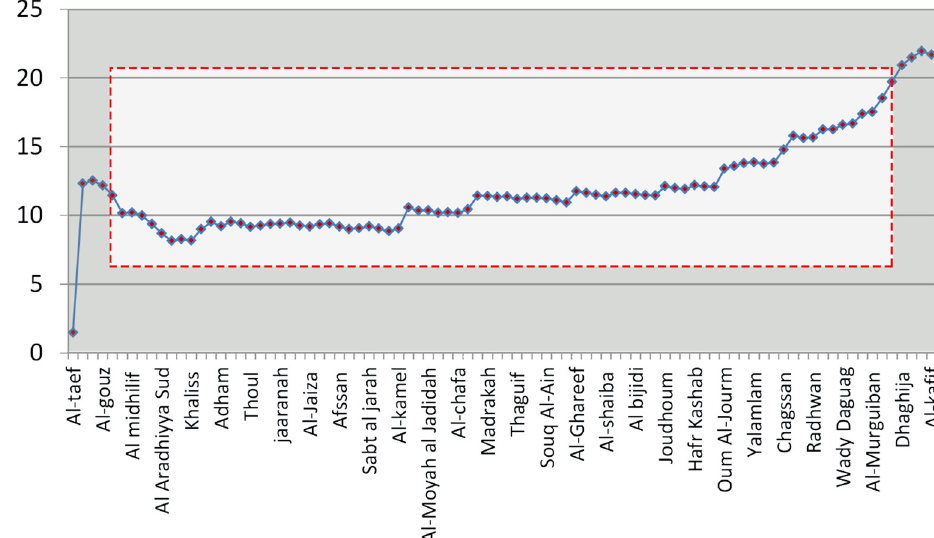
Fig. 7. Zoom shot of level 2 of the